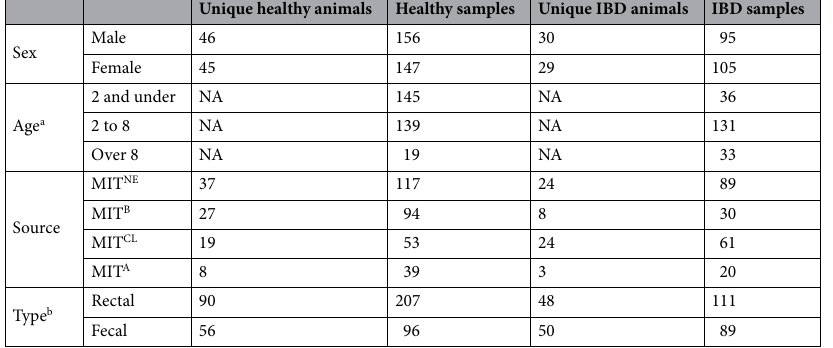
Table 1. Description of microbiome sample demographics. a Number of animals not reported as samples were collected over 2 year period and animals spanned multiple age groups. b Fecal and Rectal Swabs were often collected from the same animal, so number of animals will be